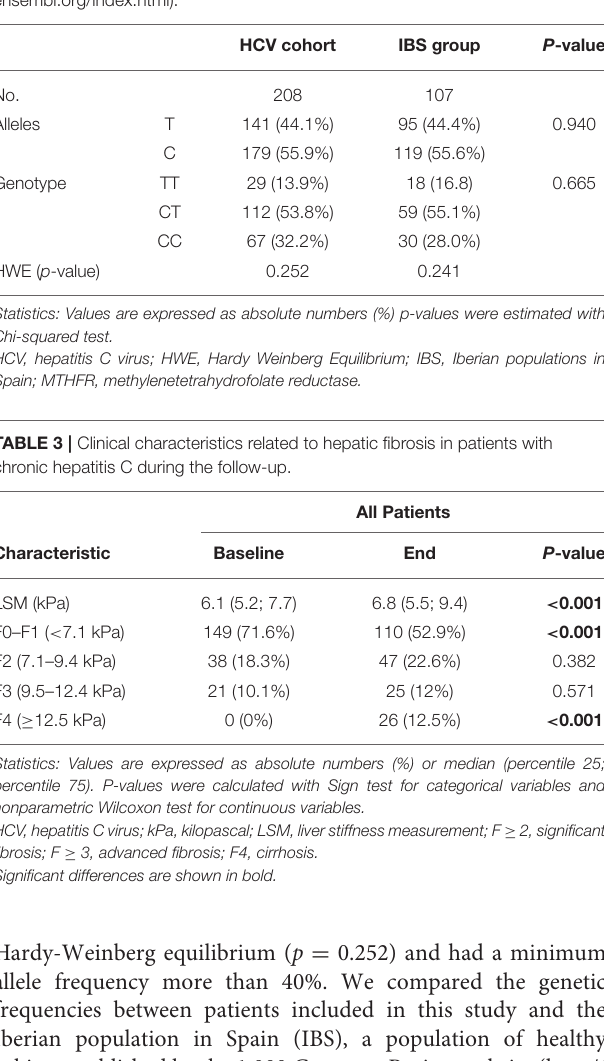
TABLE 2 | Allelic and genotypic frequencies and Hardy Weinberg Equilibrium test for MTHFR rs1801133 polymorphism in HCV-infected patients compared to